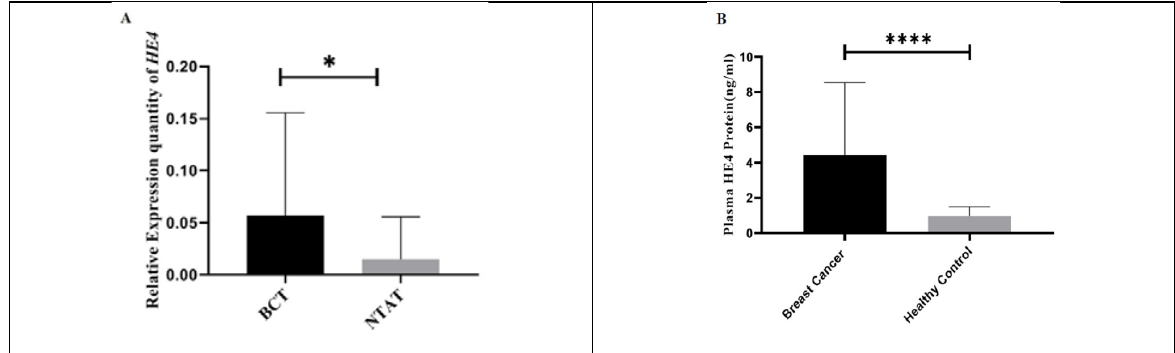
Fig. 1. HE4 relative expression in breast cancer tissues (BCT) (n=31) compared with non-tumoral adjacent tissues (NTAT) (n=31). A: The figure shows relative quantification values in 2 - ∆Ct scale. HE4 mRNA expression in BCT was significantly higher compared with NTAT ( P <0.05). B: The figure shows higher plasma HE4 levels in BC patients (n=43) compared with healthy volunteers (n = 43) ( P <0.0001). Table 1. Levels of HE4 in plasma samples from BC patients and healthy individuals. Mean plasma HE4 values for BC group was significantly higher by 3.48 ng/ml and standard error of 0.63 compared with healthy individuals Concentration of HE4 protein in plasma